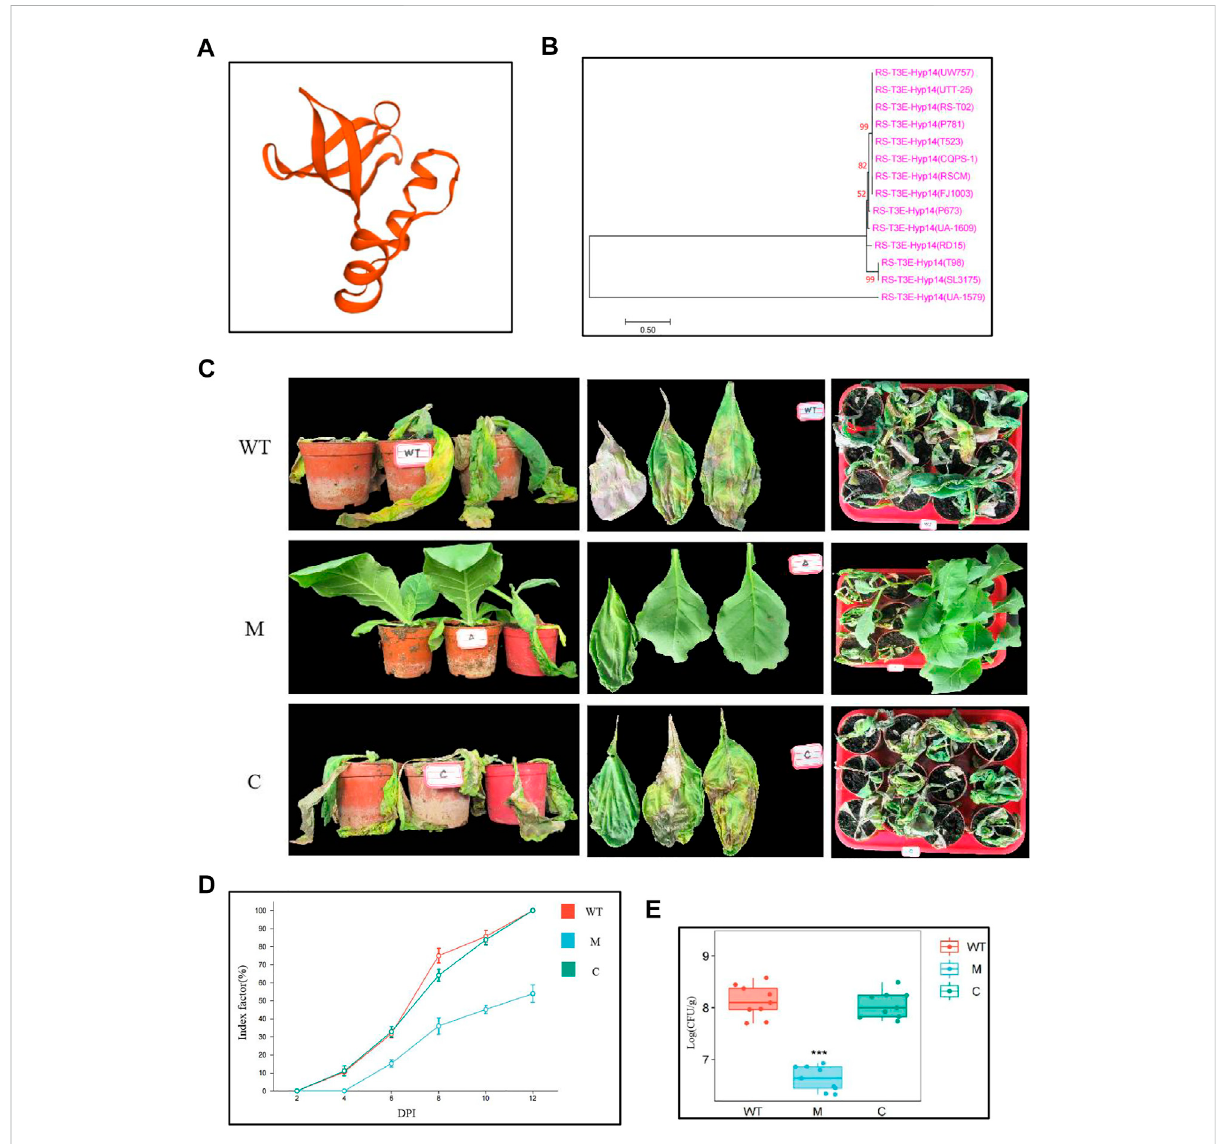
FIGURE 7 Functional identi fi cation of RS-T3E-Hyp14 (A) Tertiary structures of Rs_T3E_Hyp14 in FJ1003. (B) Molecular phylogenetic analysis of predicted RS-T3E-Hyp14 effectors. The phylogenetic tree was constructed by the maximum likelihood method. (C) Symptoms of tobacco after 8 days of inoculationwith Ralstoniasolanacearum . (D) Diseaseindexof Ralstoniasolanacearum atdifferenttimeafterinoculation (E) Colonizationof Ralstonia solanacearum intobaccostemsafterinoculationfor3